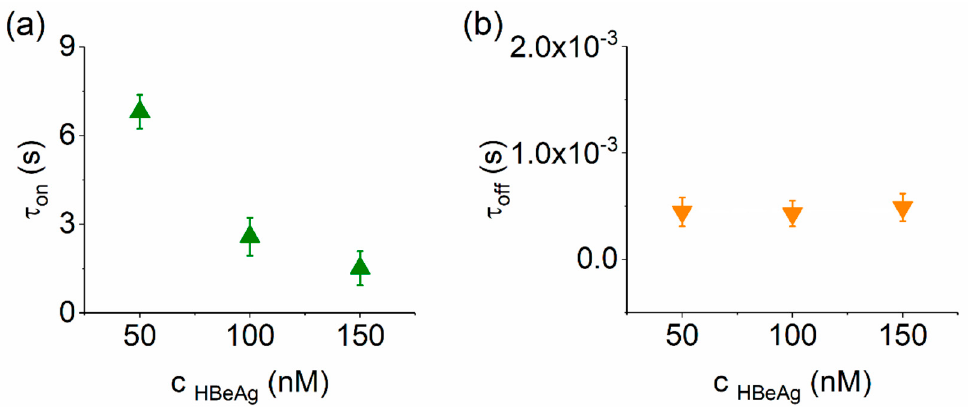
Figure 3. Quantitative analysis of HbeAg– α -HL reversible interactions. ( a ) Concentration depen- dence of the time intervals reflecting the purified HbeAg- α -HL association ( τ on ; a ) and, respectively, dissociation ( τ off ; b ), measured at an applied potential Δ V = +180 mV.